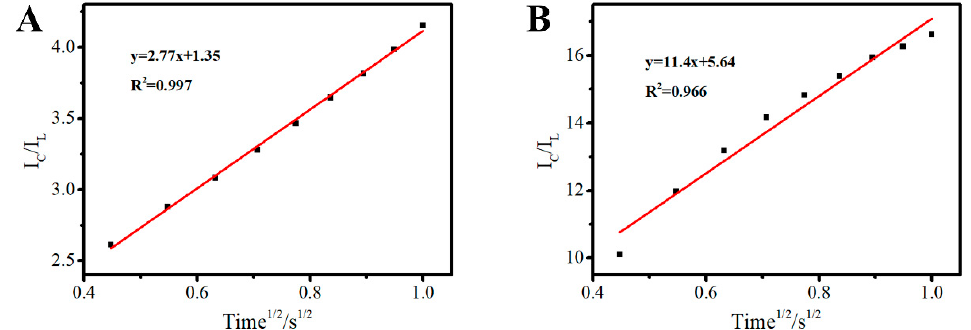
Figure 7. I C / I L -Time 1/2 of Au/FTO ( A ), 3D Au–rGO/FTO ( B ). ( I C is the catalytic current of the Figure 7. 𝐼 (cid:3004) 𝐼 (cid:3013) ⁄ -Time 1/2 of Au/FTO ( A ), 3D Au–rGO/FTO ( B ). ( 𝐼 (cid:3004) is the catalytic current of the corresponding electrode in the presence of nitrite, I L is the limiting current in the absence of corresponding electrode in the presence of nitrite, 𝐼 (cid:3013) is the limiting current in the absence of nitrite).